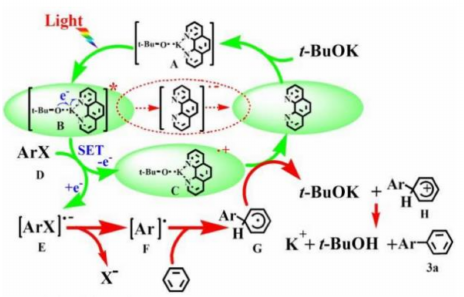
Figure 20. Proposed plausible mechanism of visible light photoredox catalyzed aryl halides reduction using base and nitrogen heterocycles as a promoter. Reprinted with permission from Ref. [70]. Copyright 2015, American Chemical Society.